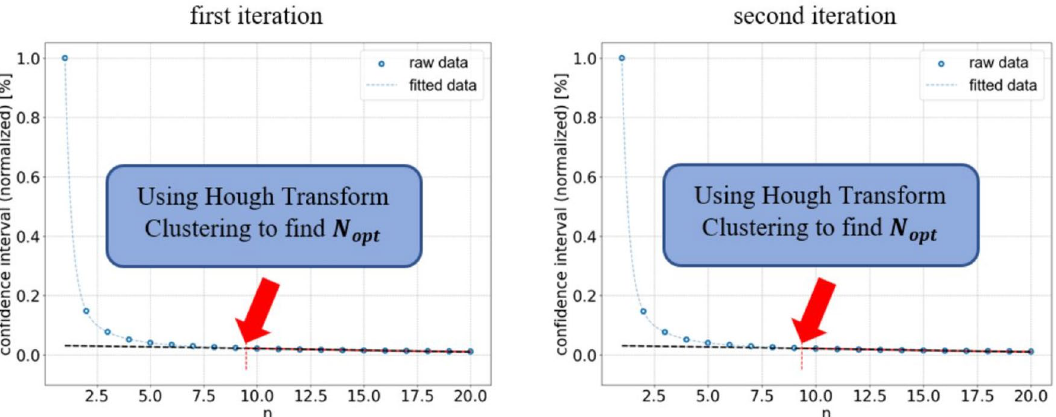
Fig. 1 Distance of the confidence interval in % for 1st iteration (left) and 2nd iteration (right). Blue dots—experimental data; blue dashed line—extended normalized data; red dashed line—clustering results belonging to data; black dashed line—extended clustering